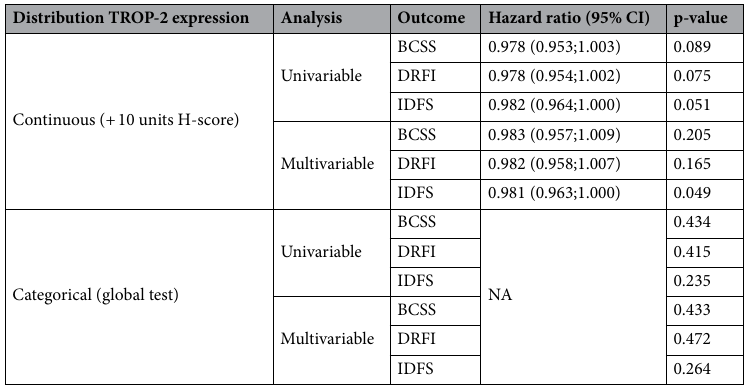
Table 5. Univariable and multivariable analyses of prognostic value of TROP-2 expression (continuous and categorical). HR hazard ratio, CI confidence interval, HR > ( < )1 increased(decreased) risk with increasing TROP2 level, corrected for: age, N-positive, T-stage, grade, AR percentage, NA not